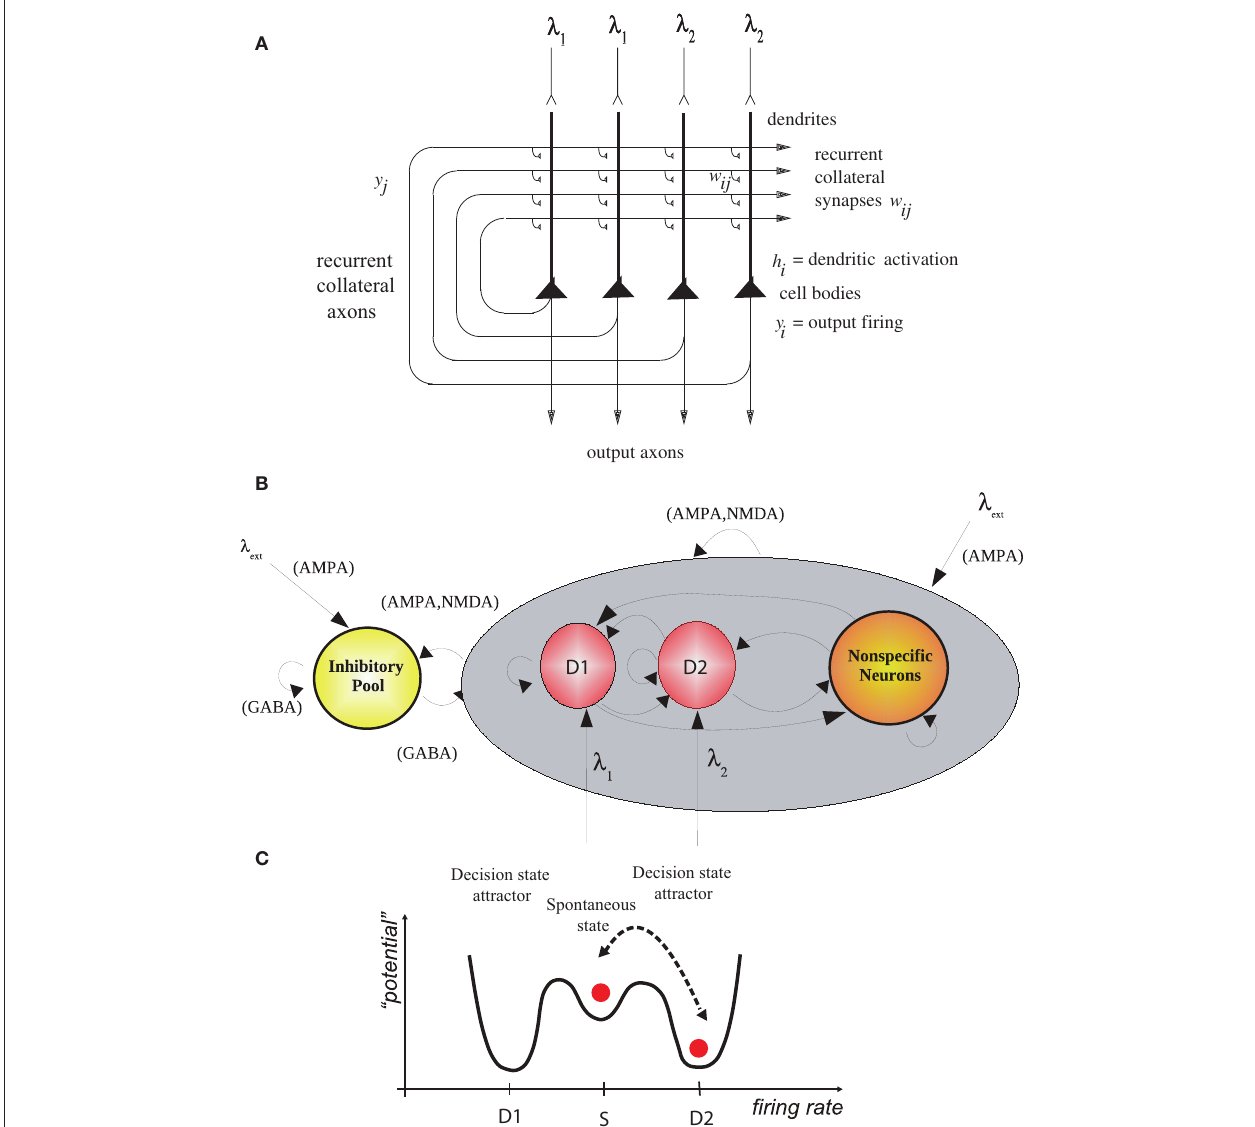
FIGURE 1 | (A) Attractor or autoassociation single network architecture for decision-making. The evidence for decision 1 is applied via the λ 1 inputs, and for decision 2 via the λ 2 inputs. The synaptic weights w ij have been associatively modified during training in the presence of λ 1 and at a different time of λ 2 . When λ 1 and λ 2 are applied, each attractor competes through the inhibitory interneurons (not shown), until one wins the competition, and the network falls into one of the high firing rate attractors that represents the decision. The noise in the network caused by the random spiking of the neurons means that on some trials, for given inputs, the neurons in the decision 1 (D1) attractor are more likely to win, and on other trials the neurons in the